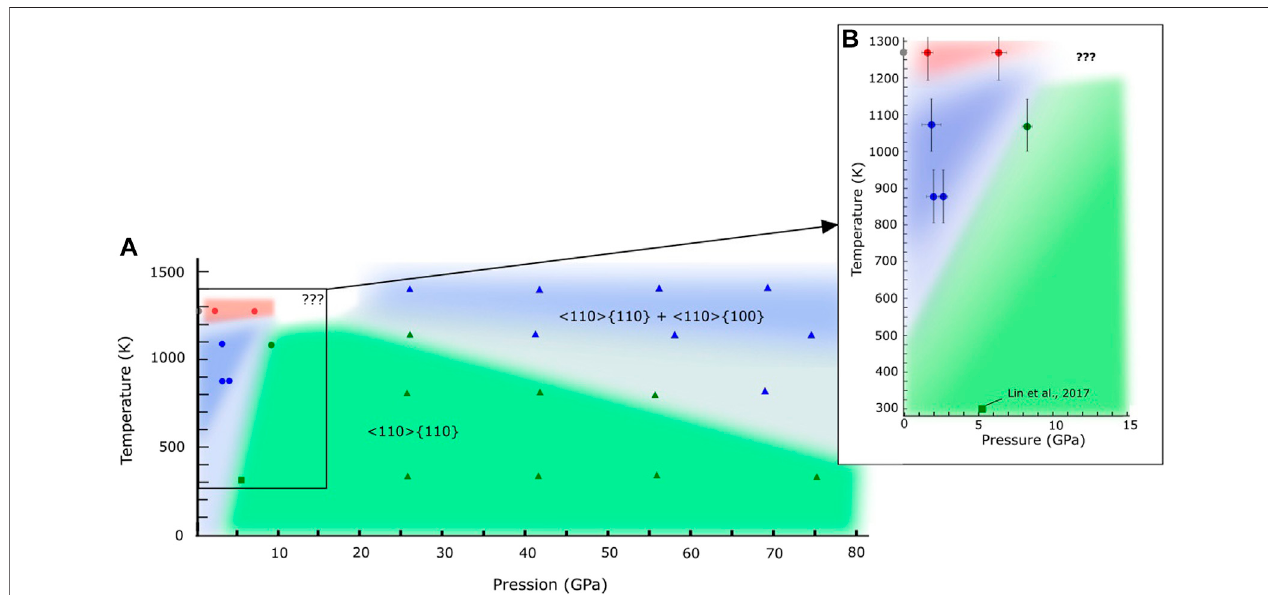
FIGURE 13 | Projection of a deformation map based on microstructural observations for MgO in pressure and temperature space (for strain rates between 10 – 6 and 10 – 5 s − 1 and μ m grain sizes). Red markers indicate deformation conditions with dominant grain boundary sliding. Green markers and blue markers correspond to deformation conditions at which textures are consistent with dislocation glide with a dominant activity of 〈 110 〉 {110} and comparable activity of 〈 110 〉 {110} and 〈 110 〉 {100} slip systems, respectively. The grey marker correspond to the reference undeformed sample. Red, blue, and green area are guides to eye highlighting the different domains for MgO plastic behavior. Circles are data from this study, the square is data from Lin et al. (2017), triangles are data from Immoor et al. (2018). (A) Summary of deformation mechanisms observed in this study and in studies of Lin et al. (2017) and Immoor et al. (2018). (B) Focus on pressures below 15 GPa.